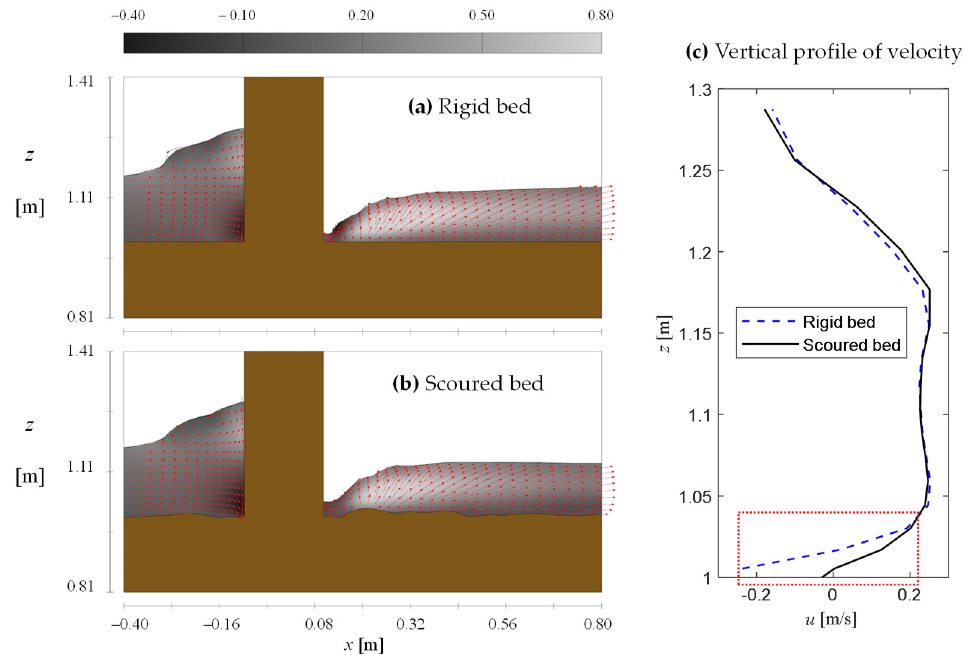
Figure 10. Comparisons of flow field and velocity profile between rigid-bed and scour-bed conditions: ( a , b ) vertical flow field at the symmetry plane of structure; ( c ) vertical profiles of velocity u in front of the structure.